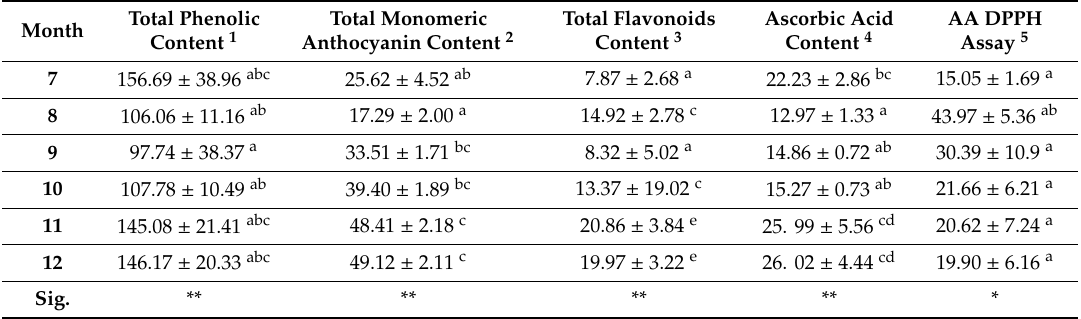
1 Results are expressed as mg of gallic acid / 100 g of fresh weight; 2 Results are expressed as mg of cyanidin-3-O- glucoside / 100 g of fresh weight; 3 Results are expressed as mg of catechin / 100 g of fresh weight; 4 Results are expressed as mg of ascorbic acid / 100 g of fresh weight; 5 Results are expressed as mg of ascorbic acid / 100 g of fresh weight. Table 7. Fruits stored at –20 ◦ C in freezer, packaged in Nanoactive B film. E ff ect of storage period on the total phenolic content, total monomeric anthocyanin content, total flavonoid content, the ascorbic acid content, and the antioxidant activity DPPH parameters in red raspberries (cv. Erika). The results are the mean of three replicates ± Standard Deviation. ** ( P ≤ 0.01). The letters represent the significant di ff erence vertically at P ≤ 0.05.